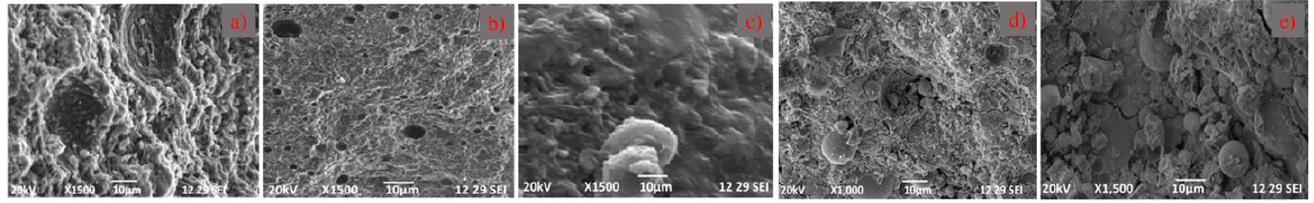
Figure 12. SEM images before exposure; ( a ) concrete without nanomaterials; ( b ) concrete with NC; ( c ) concrete with NF; ( d ) concrete with NS; ( e ) concrete with NM.